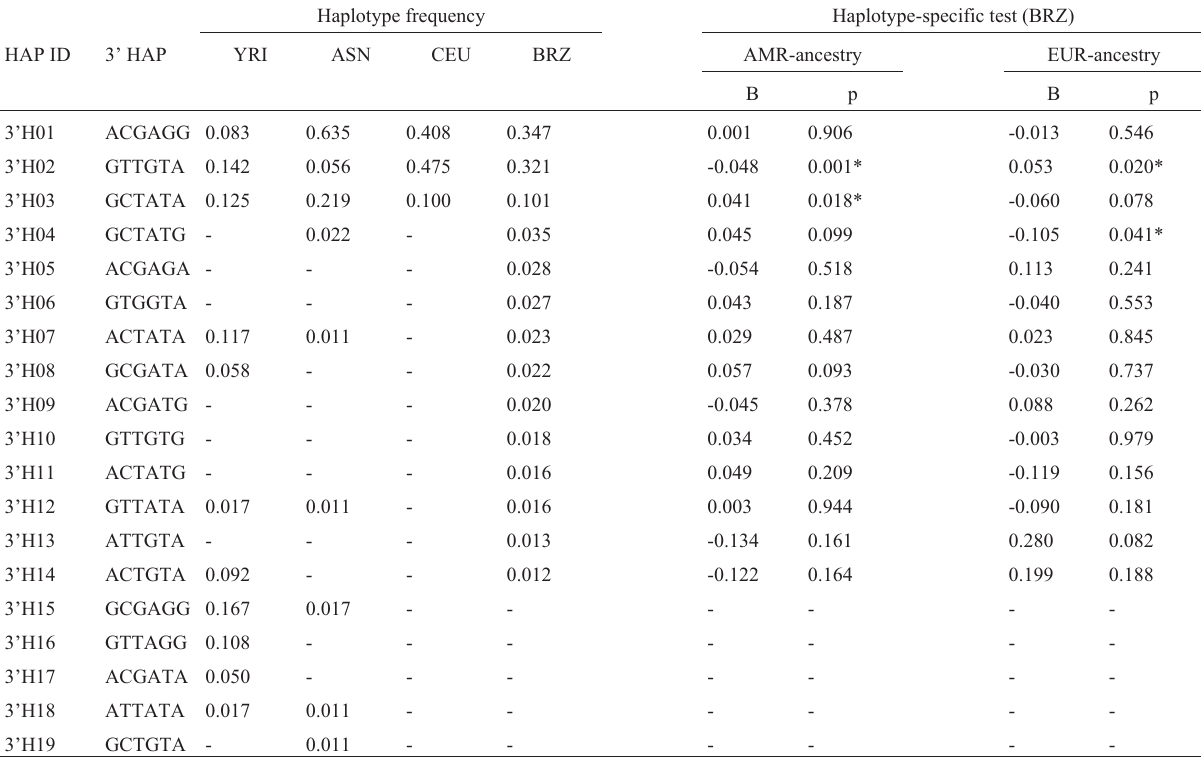
Table 4 - Distribution of the 3’ haplotype frequencies among different populations and the association between Brazilian populations and European (EUR) and Amerindian (AMR) ancestry. Haplotype